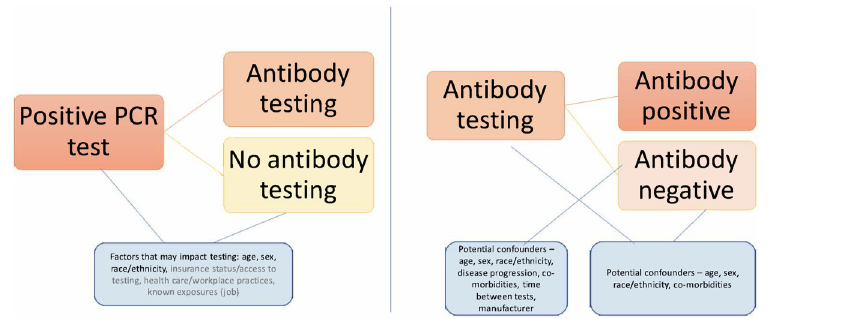
Fig 3. Factors potentially associated with serological testing. Pepe, 2001